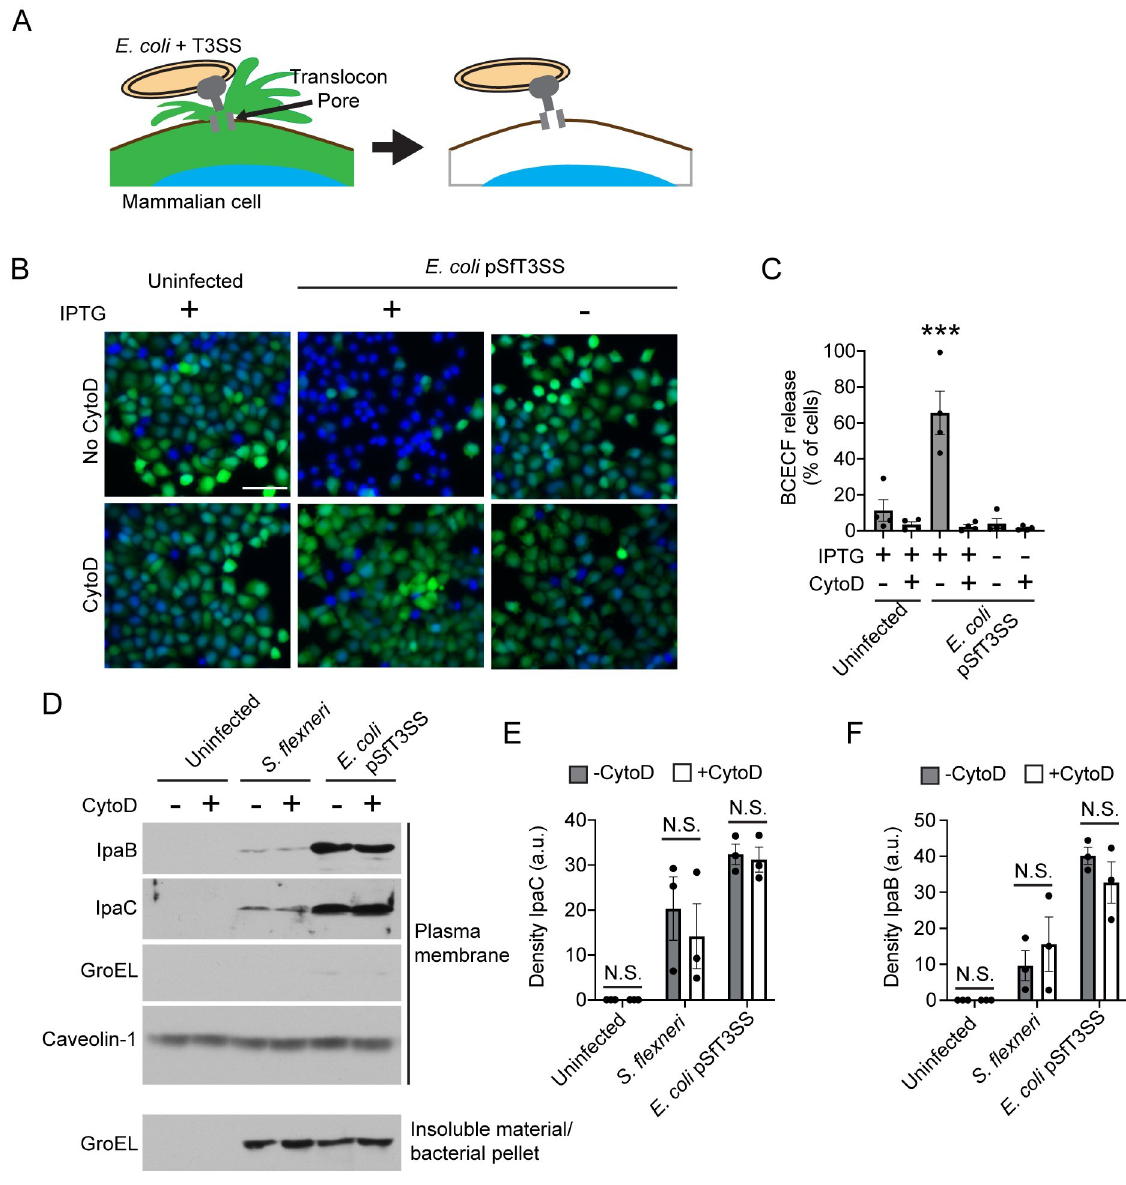
Fig 2. Actin polymerization is required to form open translocon pore complexes. (A) Schematic depiction of BCECF dye release from cells that contain a plasma membrane-embedded T3SS translocon pore delivered by E . coli producing the S . flexneri T3SS ( E . coli pSfT3SS). (B-C) Effect of CytoD on dye release during E . coli pSfT3SS infection at a MOI of 100 of HeLa cells preloaded with BCECF. (B) Representative fluorescent images of cells at 60 minutes of infection. Blue, DNA (Hoechst); green, BCECF; scale bar, 100 μ m. (C) Percentage of cells that released BCECF dye. Data points are independent experiments. Data are the mean ± SEM of four independent experiments. ��� , p < 0.001 by one-way ANOVA with Tukey’s post hoc test; WT is statistically different from all other conditions. (D-F) The effect of CytoD on the abundance of translocon pore proteins in the plasma membrane during infection of HeLa cells with S . flexneri or E . coli pSfT3SS at a MOI of 500. (D) Representative western blots. IpaB and IpaC, S . flexneri T3SS translocon pore proteins; GroEL, bacterial cytoplasmic protein; caveolin-1, plasma membrane protein. (E-F) Quantification of levels of IpaC (E) or IpaB (F) in the plasma membrane fraction. Data points are independent experiments; data are the mean ± SEM of three independent experiments. N.S., not significant by two-way ANOVA with Sidak post hoc